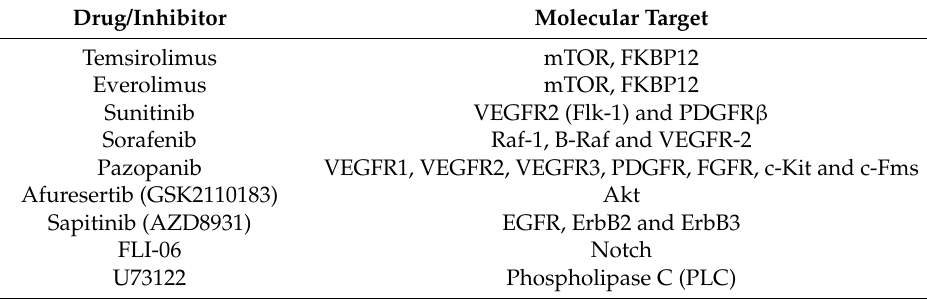
Table 2. Drugs/inhibitors used in this study and their molecular targets.